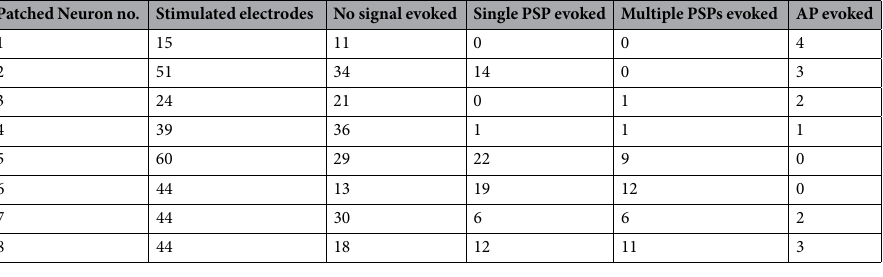
Table 1. Mapped connections upon randomized HD-MEA stimulation for eight patched cells. Number of synaptic connections for eight postsynaptic neurons, where Neurons 6, 7 , and 8 were patched in the same